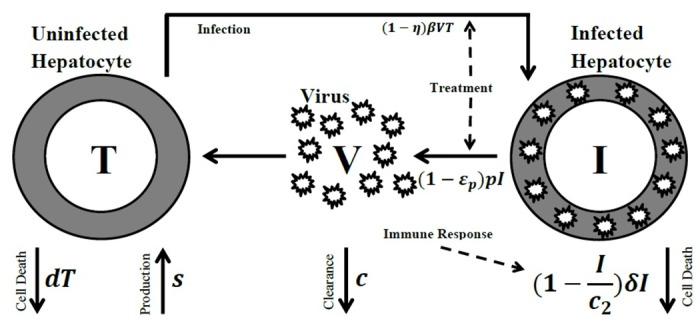
Flowchart of Model (1).